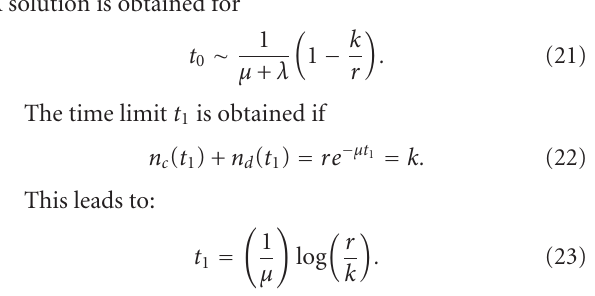
disconnection and peer departure rates, which are respec- tively named λ and μ , are considered constant. Disconnected holders may reconnect at constant rate λ (cid:2) . Additionally, holders do not just leave the system after a crash but may also pertain to state “left” if they destroy blocks they